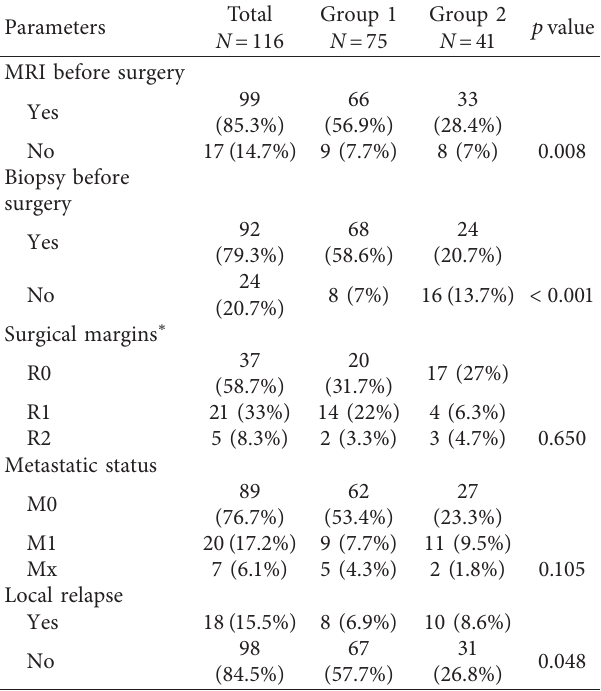
Table 2: Quality criteria for the management of soft-tissue